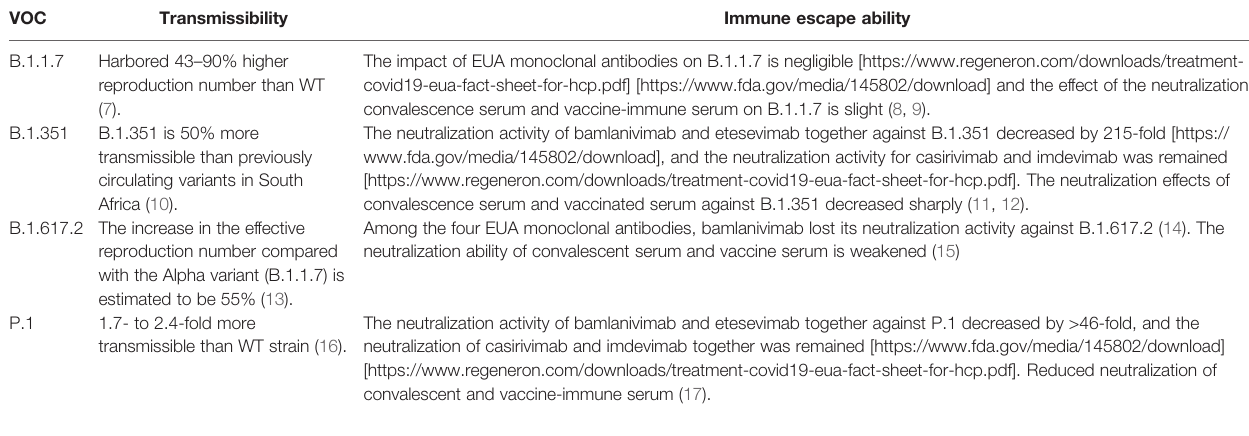
TABLE 1 | The transmissibility and immune escape ability of four